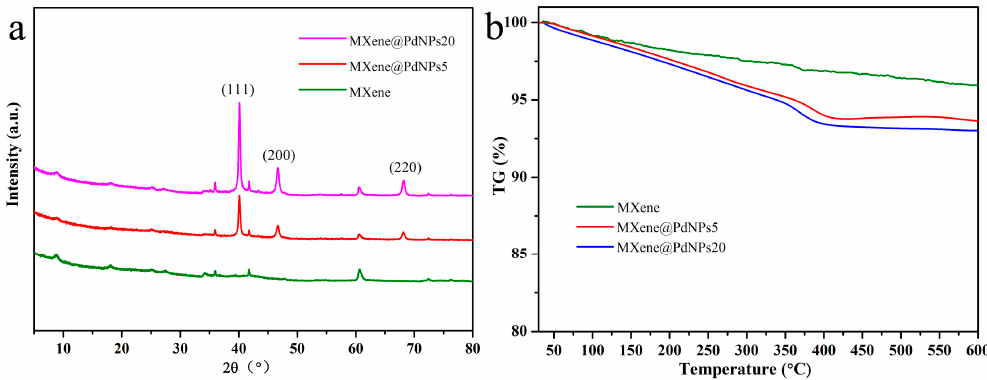
Figure 2. XRD patterns ( a ) and TG curves ( b ) of prepared MXene composites.